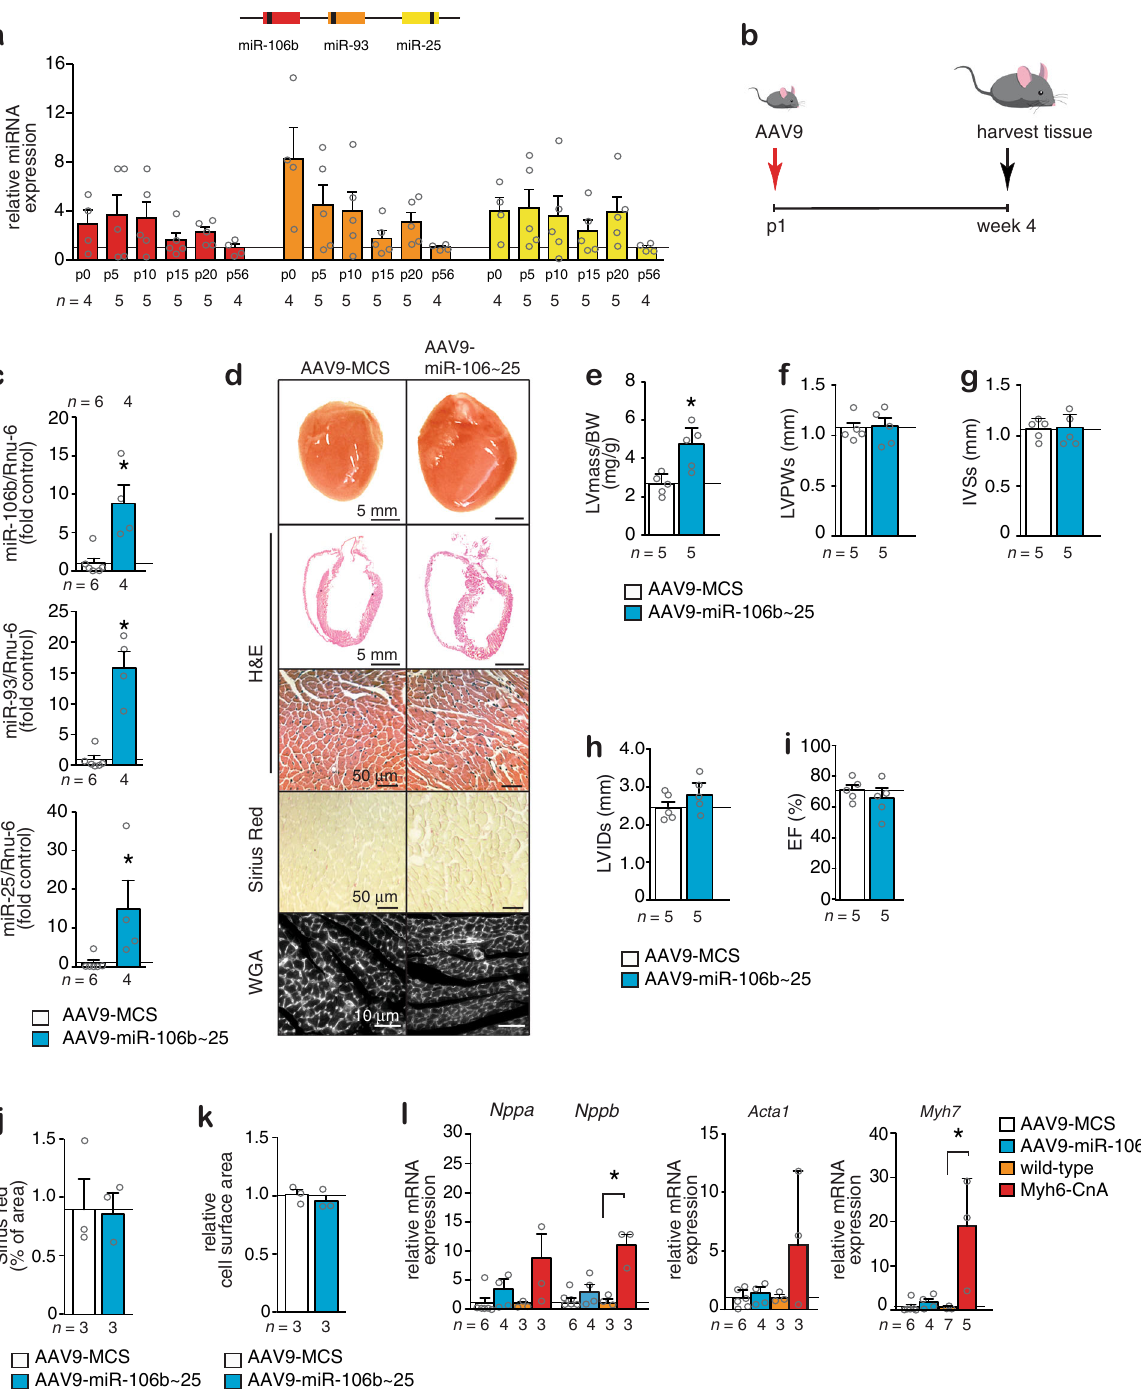
Fig. 2 Overexpression of the miR-106b~25 cluster induces cardiac growth with sustained function. a Real-time PCR analysis of miR-106b , miR-93 , and miR-25 abundance in mouse hearts at postnatal day 0 (p0), p5, p10, p15, p20, and p56 (2 months) of age. b Design of the study. c Real-time PCR analysis of miR-106b , miR-93 , and miR-25 abundance in AAV9-MCS versus AAV9-miR-106b~25 hearts, 4 weeks after injection. d Representative images of whole hearts (top panels), H&E-stained sections of four-chamber view (second panel), high magni fi cation H&E sections (third panel), Sirius Red stained sections (fourth panel), and WGA-stained ( fi fth panel) sections. Quanti fi cation of e LV/BW ratio, f LVPWs, g IVSs, h LVIDs, and i EF of mice that received AAV9- MCS or AAV9-miR-106b~25. Quanti fi cation of j the fi brotic area by Sirius Red staining and k the cell surface areas by WGA-staining. l Real-time PCR analysis of Nppa , Nppb , Acta1 , and Myh7 in hearts from mice that received AAV9-MCS or AAV9-miR-106b~25; or WT or calcineurin transgenic (Myh6- CnA) mice, a mouse model for heart failure, n refers to number of animals. * P < 0.05 vs corresponding control group (error bars are s.e.m.). Statistical analysis consisted of a two-tailed Student ’ s t -test ( c , e – k ) or a One-way ANOVA followed by Dunnett multiple comparison test ( l ). Source data are provided as a Source data fi